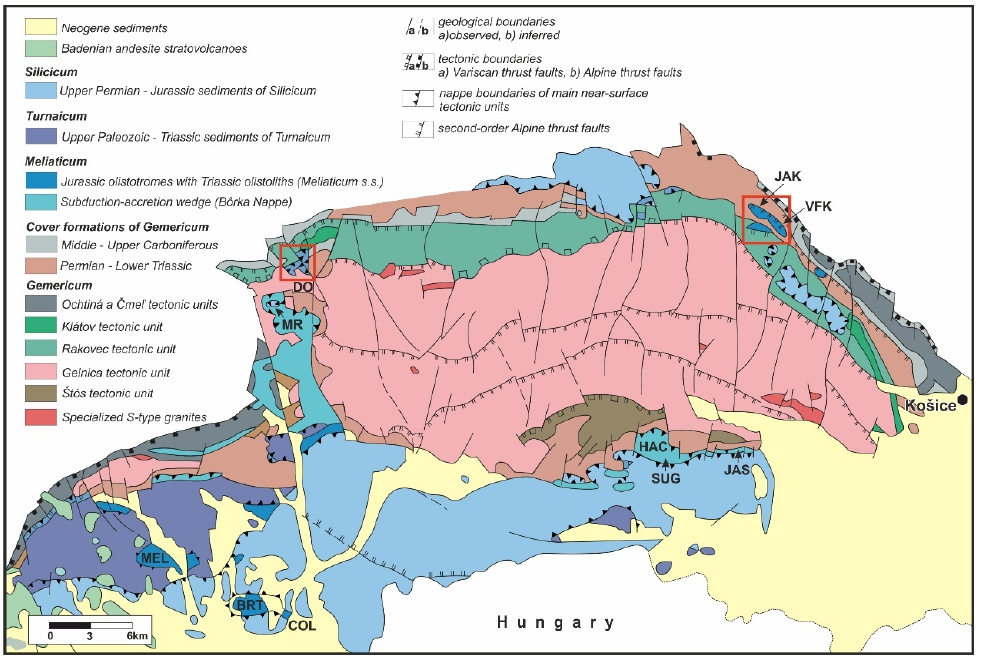
Figure 2. Tectonic map of the southeastern part of the IWC (modified from [43,44]). Red squares— investigated areas in greater detail at Dobšiná (DO), Jaklovce (JAK), and Ve ľ ký Folkmár (VFK). Additional samples are from Malý Radzim Hill near Brdárka (MR), Meliata (MEL), Bretka (BRT), Č oltovo (COL), Ha č ava (HAC), and Šugov Valley (SUG); and Jasov (JAS).